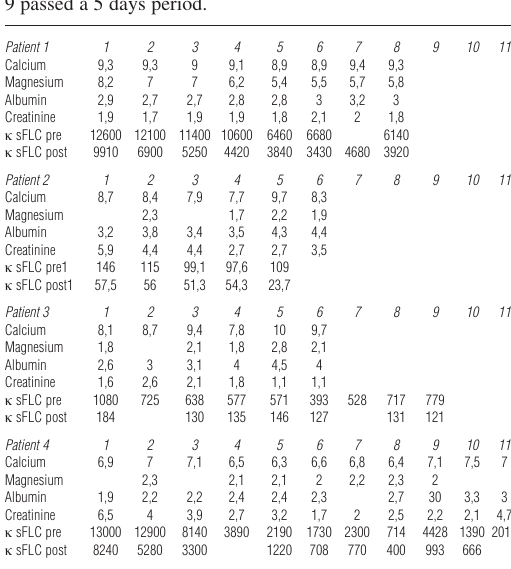
specific antisera. Results. Patient one, a 61 year old man,